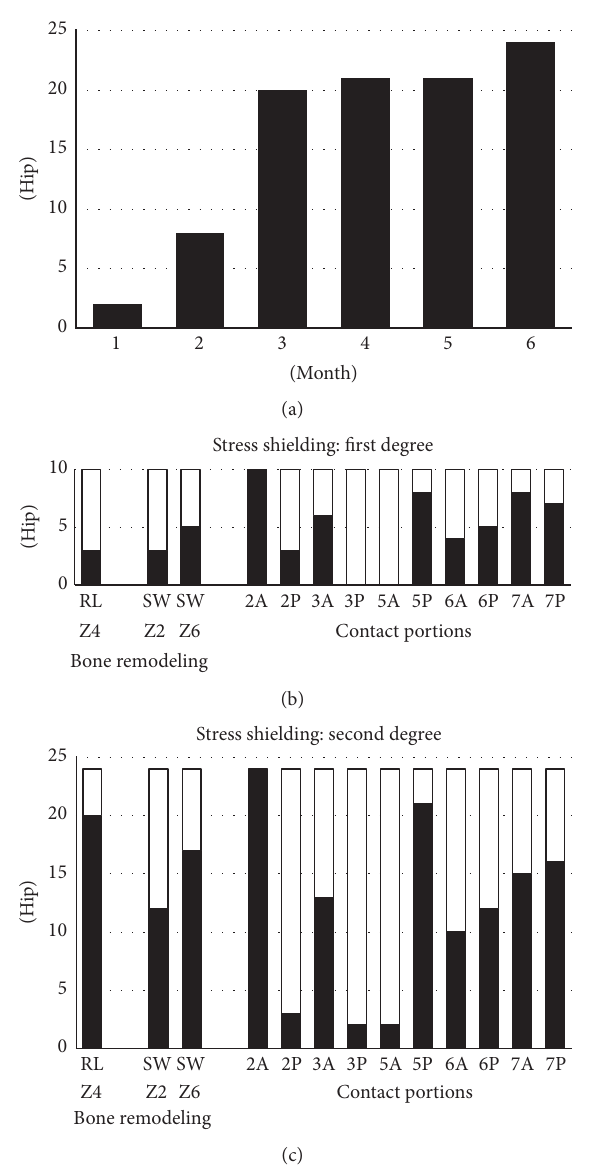
Figure 4: Cumulative frequency of the appearance of spot welds over time (a). Stress shielding of the first (b) and second or greater (c) degree is shown. Solid bars indicate the numbers of hips showing bone remodeling (left) and contact with the bone by portion (right), while the open bars indicate the number of hips without bone remodeling (left) and bone contact